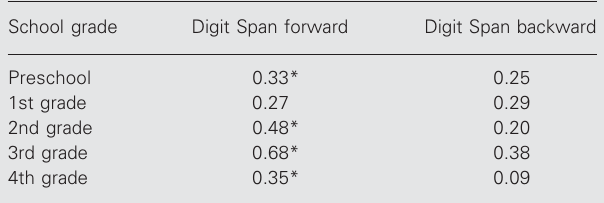
Table 6. Pearson correlations between BCPR and Digit Span by school